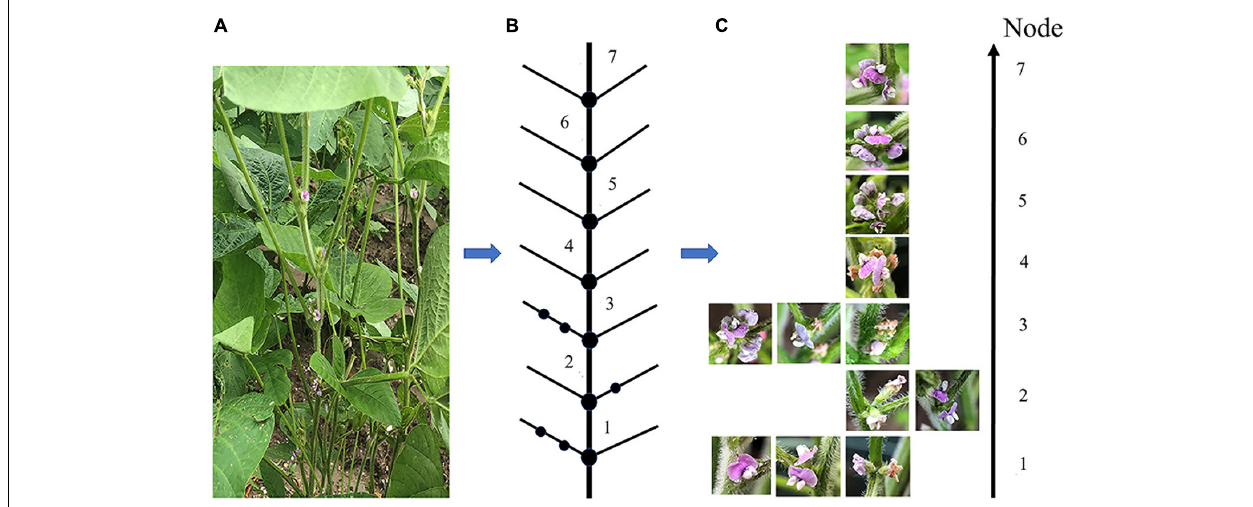
division of the soybean flower and pod datasets is presented in Table 2